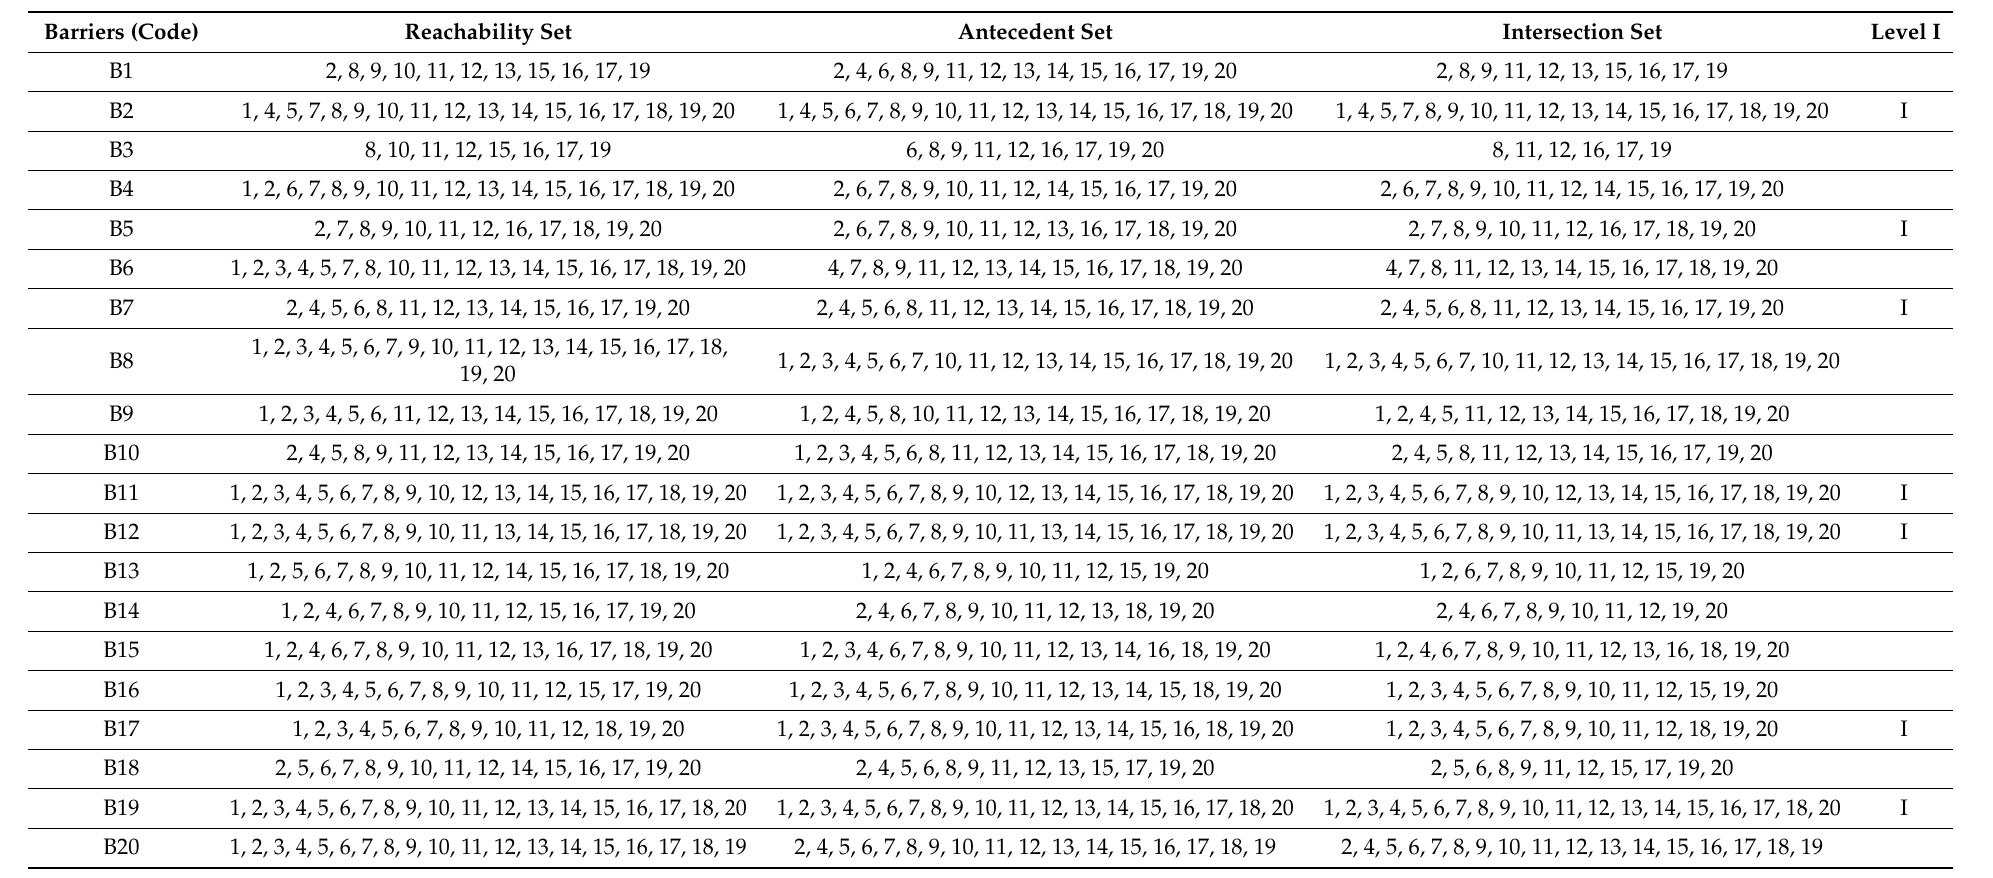
Table 6. RM level partition matrix